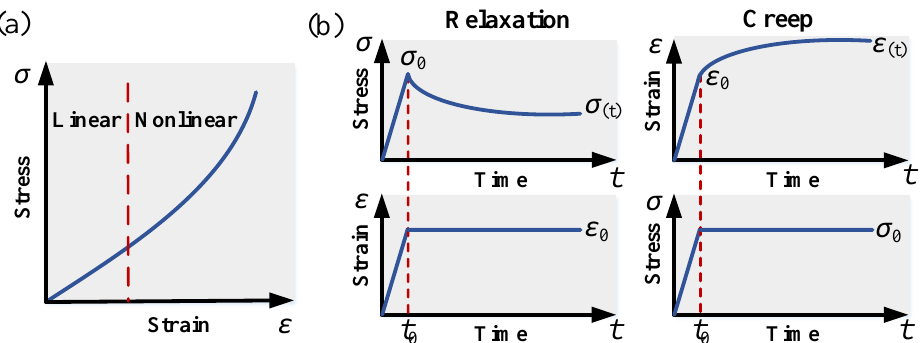
Figure 2. Constitutive responses of soft biomaterials. ( a ) Nonlinear stress–strain ( σ − ε ) behavior, in which the stress profile can be considered linear under small strain; and ( b ) time-dependent mechanical behavior: stress-relaxation ( left ) and creep ( right ).